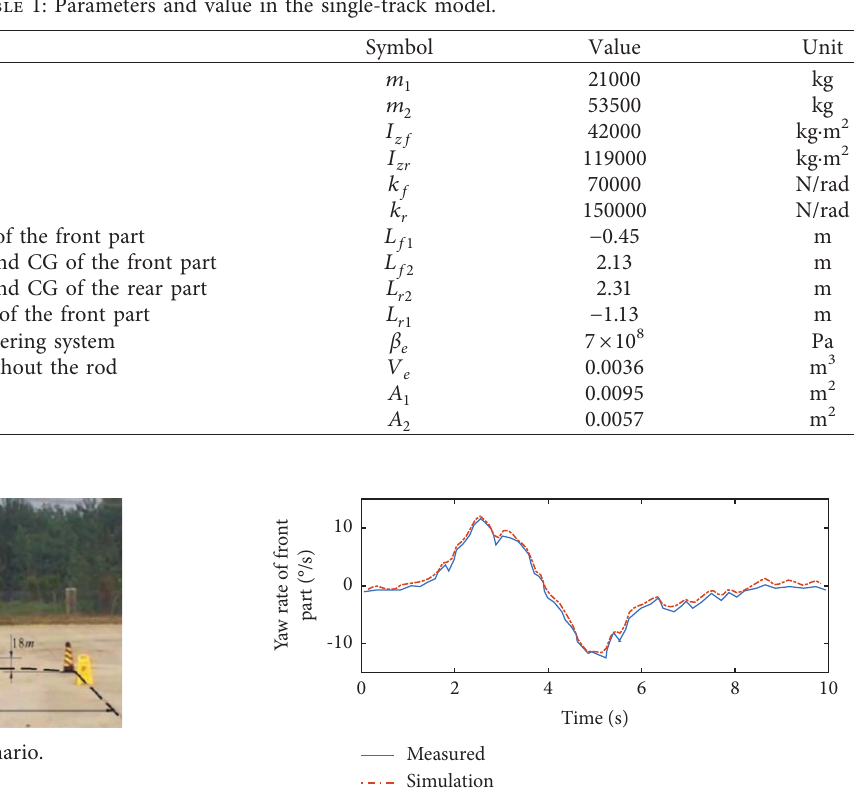
Figure 5: Comparison of vehicle yaw rate in field test and